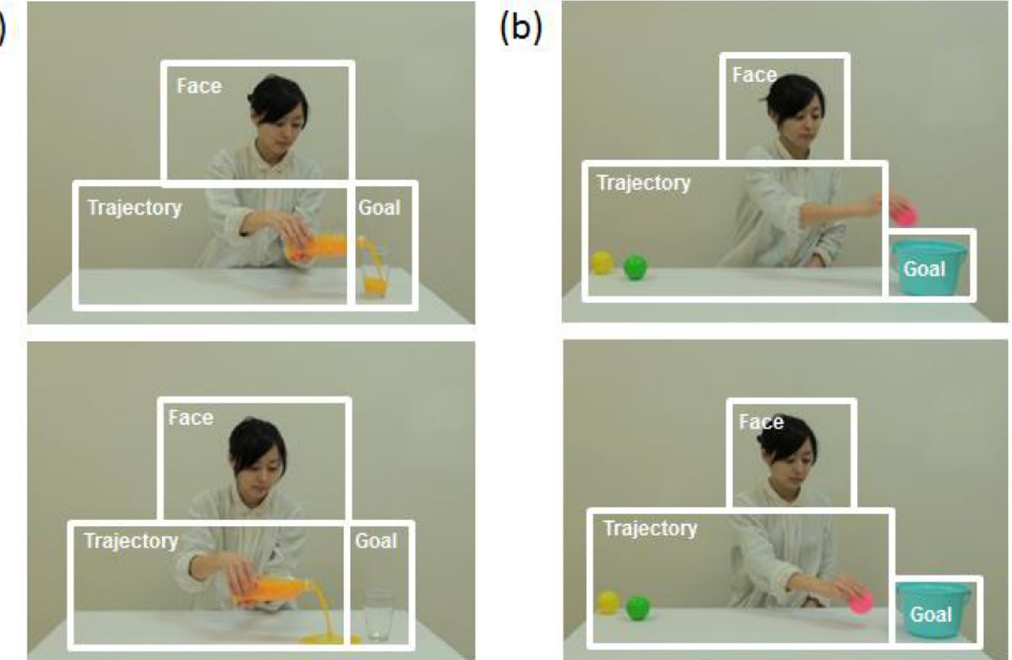
Fig 1. A selected scene from the video stimulus used in Experiments 1, 2, and 3 and areas of interest (AOIs) for the analyses. (a) Experiments 1 and 3: A female human adult actor sits in front of a table and pours some juice from a bottle into a clear glass cup (congruent action, upper) or pours some juice onto the floor (incongruent action, below). The videos of both the congruent and incongruent actions lasted 14.0 s. (b) Experiment 2: A female human adult actor sits at a table and places balls into a container (congruent action, upper) or places balls on the floor (incongruent action, below). The video of the congruent action lasted 13.5 s, and the video of the incongruent action lasted 13.9